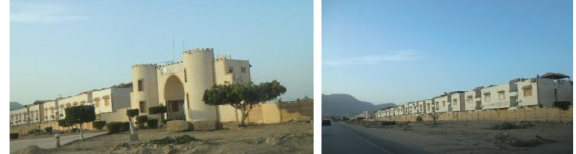
Figure 4 . Early touristic resorts and hotels. (Source: Author)